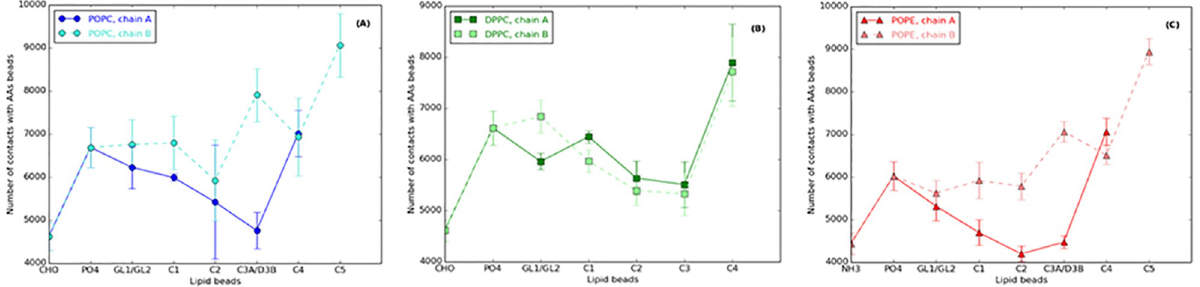
Fig 3. Number of contacts between each protein bead and each lipid bead type. (A) POPC, (B) DPPC, and (C) POPE, as obtained from the 15 μ s CG MD runs at P = 1.01325 bar and T = 310 K. The D3B bead in POPC and POPE is replaced by a C3B in DPPC. Lines between the points are present to guide the reading of the